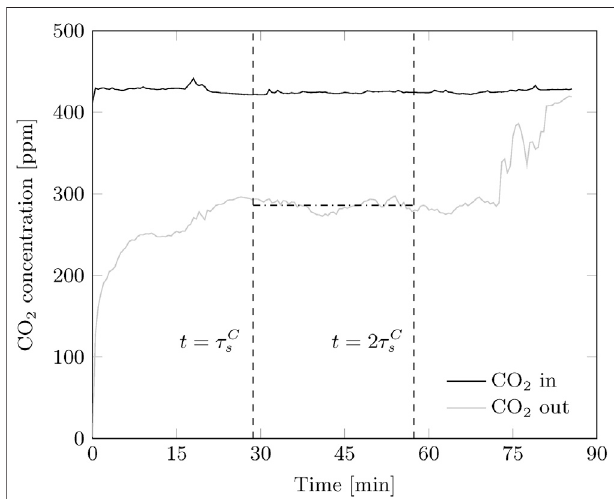
FIGURE 6 | Typical CO 2 concentration pro fi les for a continuous adsorption experiment. A steady-state is observed after the sorbent is refreshed once. The experiment ends when all sorbent left the reactor.